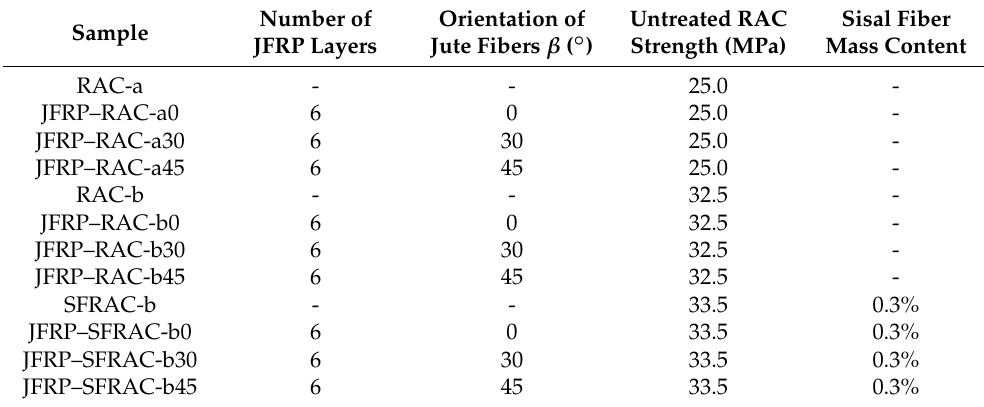
Table 6. Test matrix of cylindrical specimens in this study.